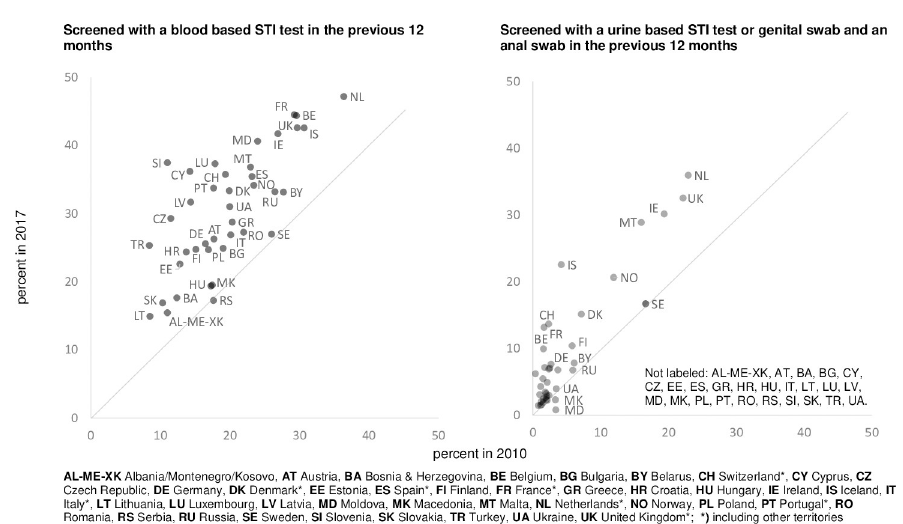
Fig 2. Explanatory variables. Panel of 2 country-level scatter plots (interventions): Screened with a blood based STI test in the previous 12 months; Screened with a urine based STI test or genital swab and an anal swab in the previous 12